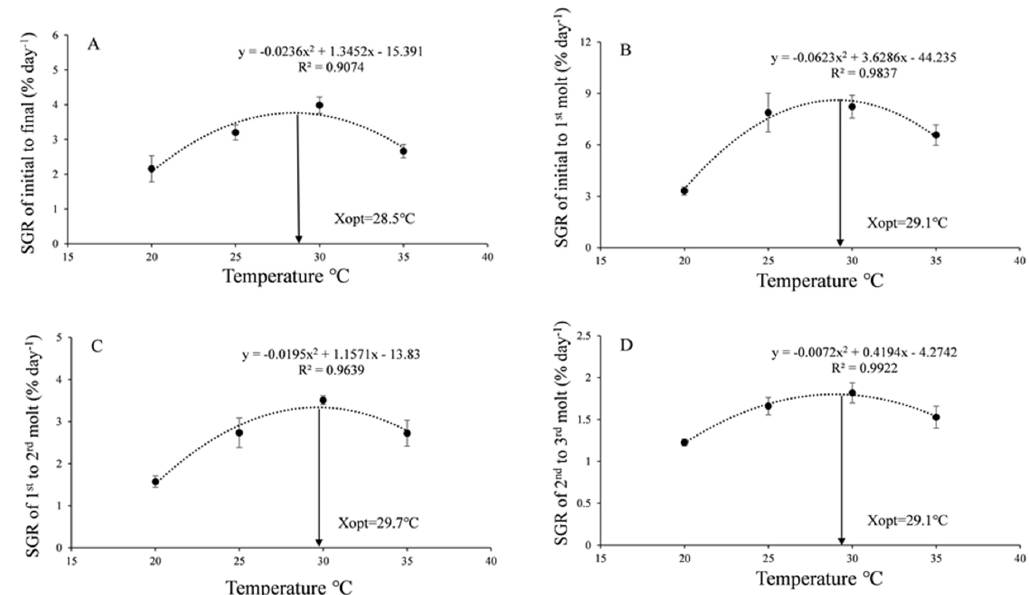
Figure 2. Relationship between the temperature and the SGR of initial to 1st molt ( A ), 1st to 2nd molt ( B ), 2nd to 3rd molt ( C ), and initial to final ( D ), respectively. Where Xopt means the optimal temperature for the maximum SGR.